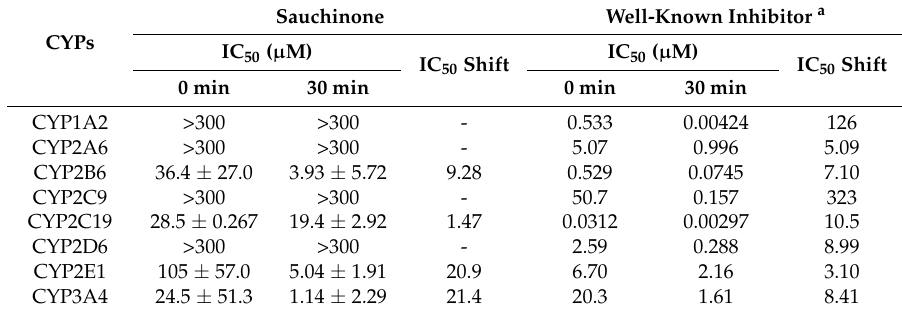
Figure 3. IC 50 curves of sauchinone for TDI on CYP1A2, CYP2A6, CYP2B6, CYP2C9, CYP2C19, CYP2D6, CYP2E1, and CYP3A4 in HLMs. Y-axis is expressed as the remaining percentage of activity with sauchinone compared with the control (without sauchinone). Symbols of ‘ ● ’ and ‘ ○ ’ represent 0 and 30-min inactivation incubation, respectively. Table 2. IC 50 ( µ M) values of sauchinone and each well-known reversible inhibitor on the respective CYP activity in HLMs. Also shown are the IC 50 values and IC 50 shifts of sauchinone and each well-known time-dependent inhibitor on each CYP’s activity in HLMs.